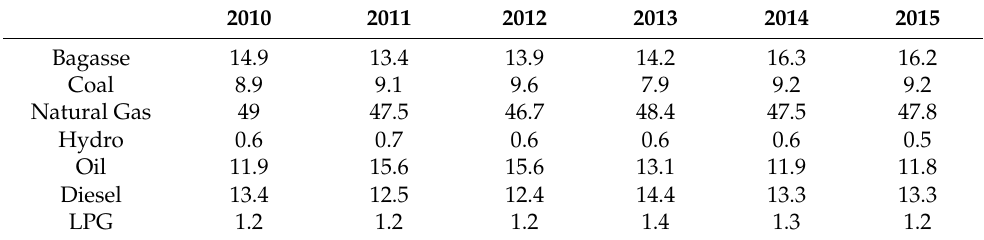
Table 8. Fuel mix in auto- and cogeneration units (%)